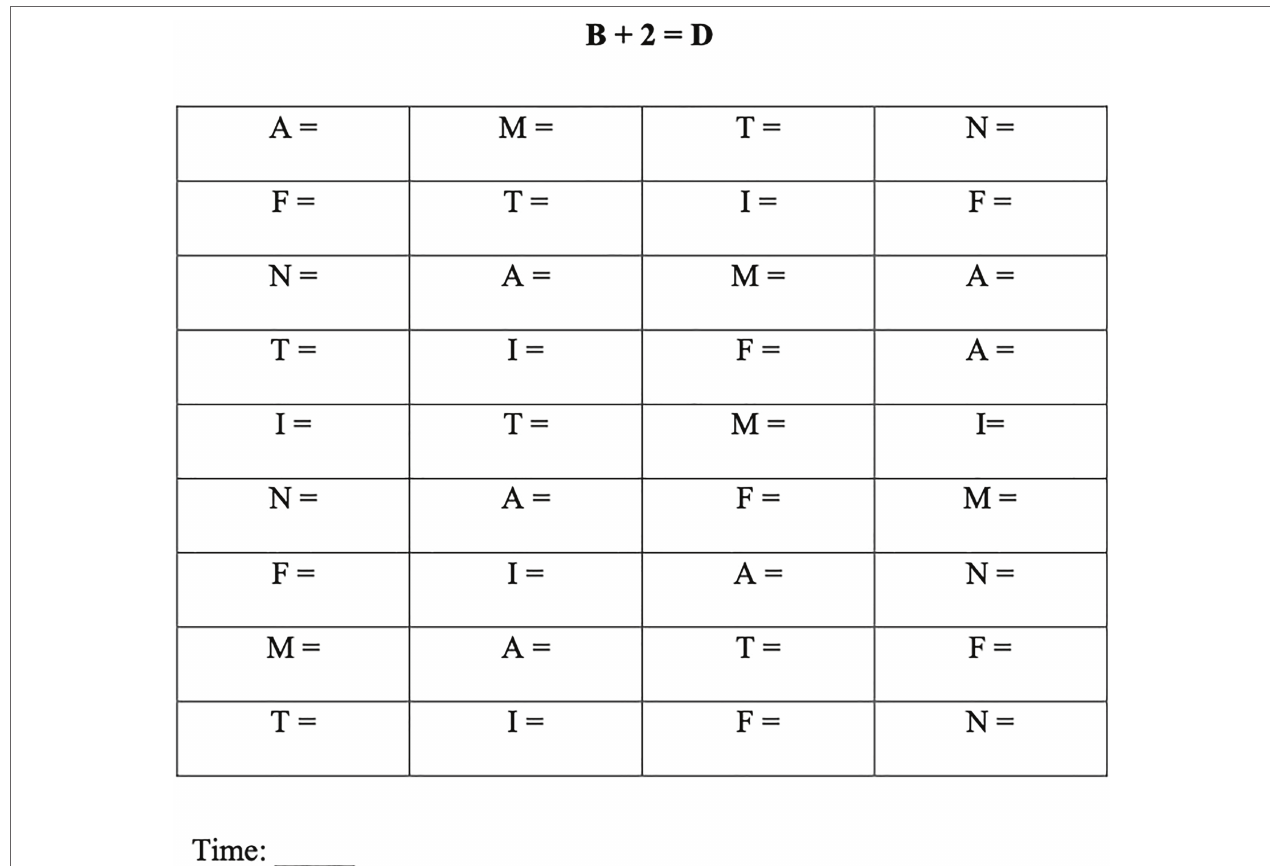
FIGURE 2 | Example of a matrix of the experimental task. The rule is presented on top of the